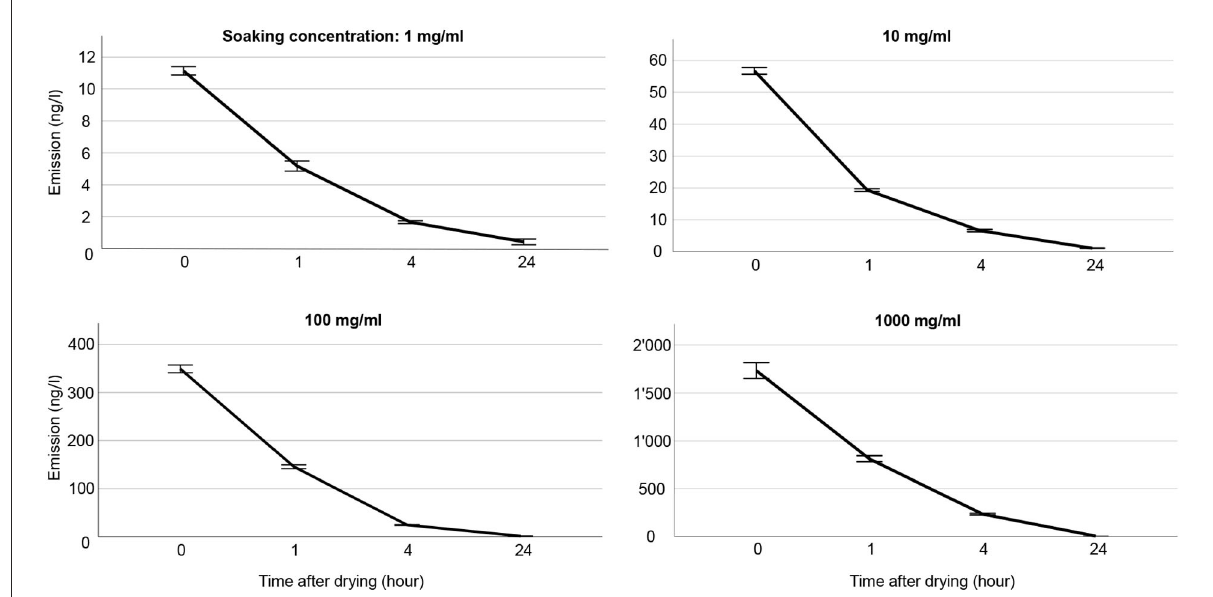
FIGURE2 Volatile emission rate from silicone septa for benzaldehyde. Five trials were done for each soaking concentration and time points after drying. For volatile collection, a sampling rate of 200ml min − 1 ( = 12 l/h) was used, thus, to convert units into ng/h, amounts should be multiplied by